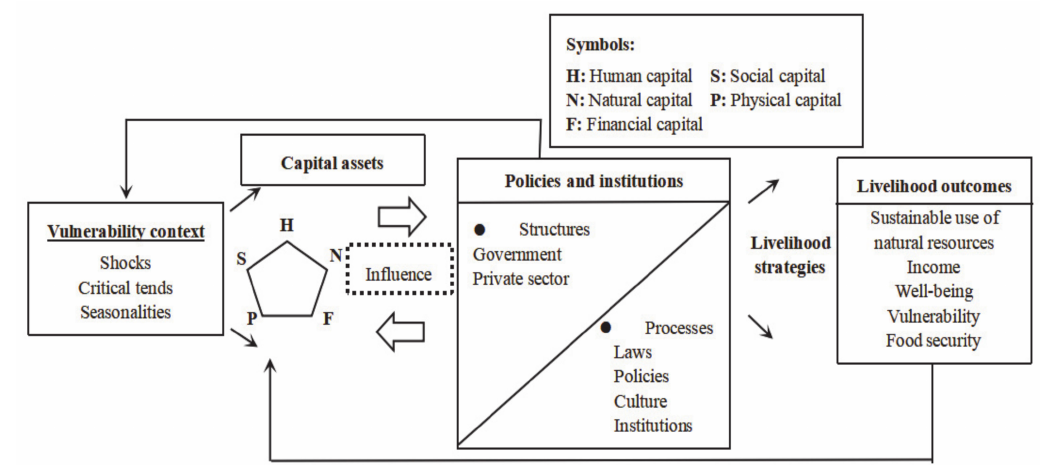
Figure 1. Sustainable livelihoods approach